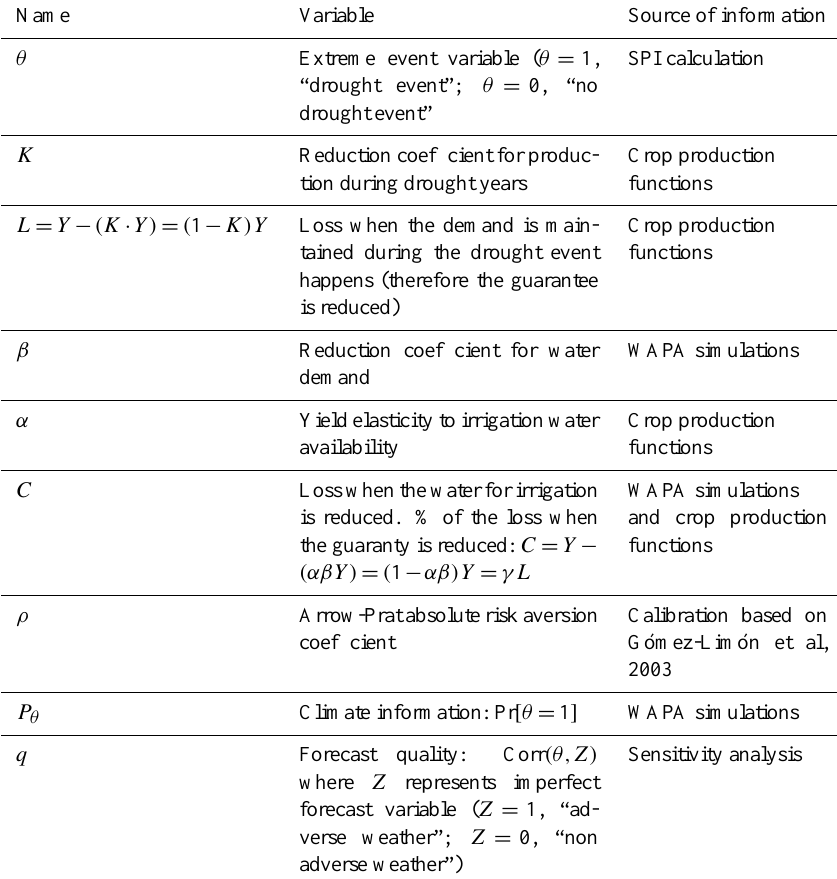
Table 5. Description of the variables included in the decision making